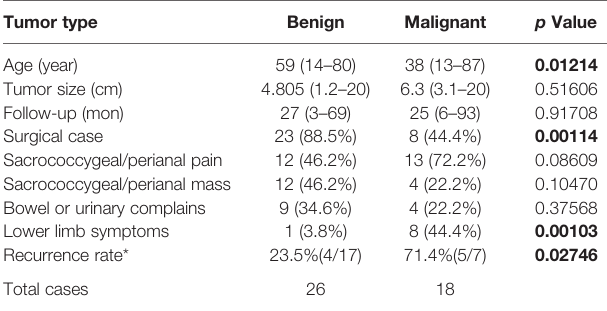
TABLE 2 | Comparison between patients with benign and malignant tumors. Tumor type